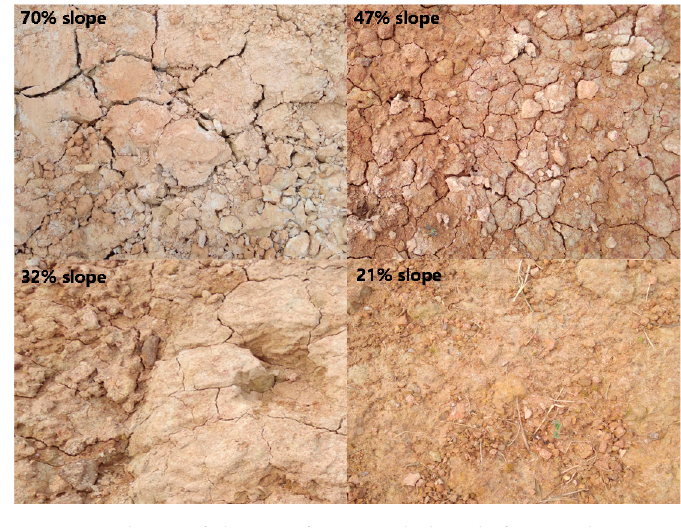
Figure 10. Photos of slope surface morphology before Moderate run.